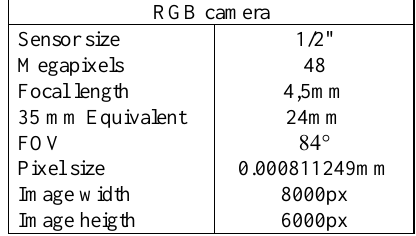
Table 3 . RGB camera parameters